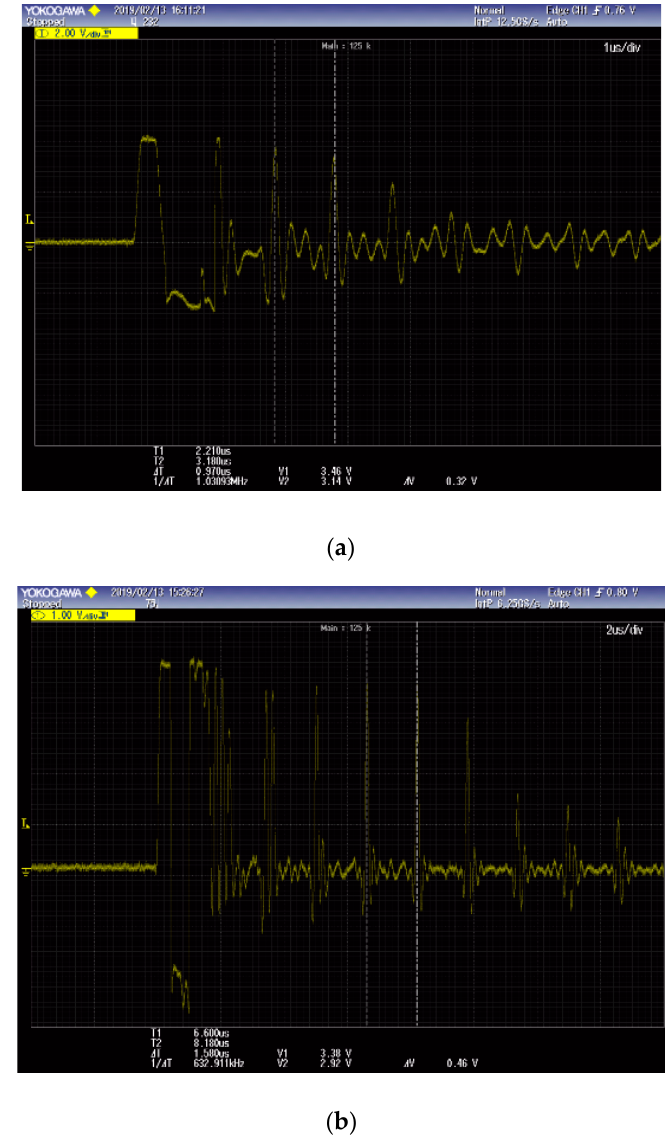
Figure 5. Ultrasonic echo pulse measurements: longitudinal wave ( a ), transverse wave ( b ). Table 2. Test results of E, G and ν in UPET.